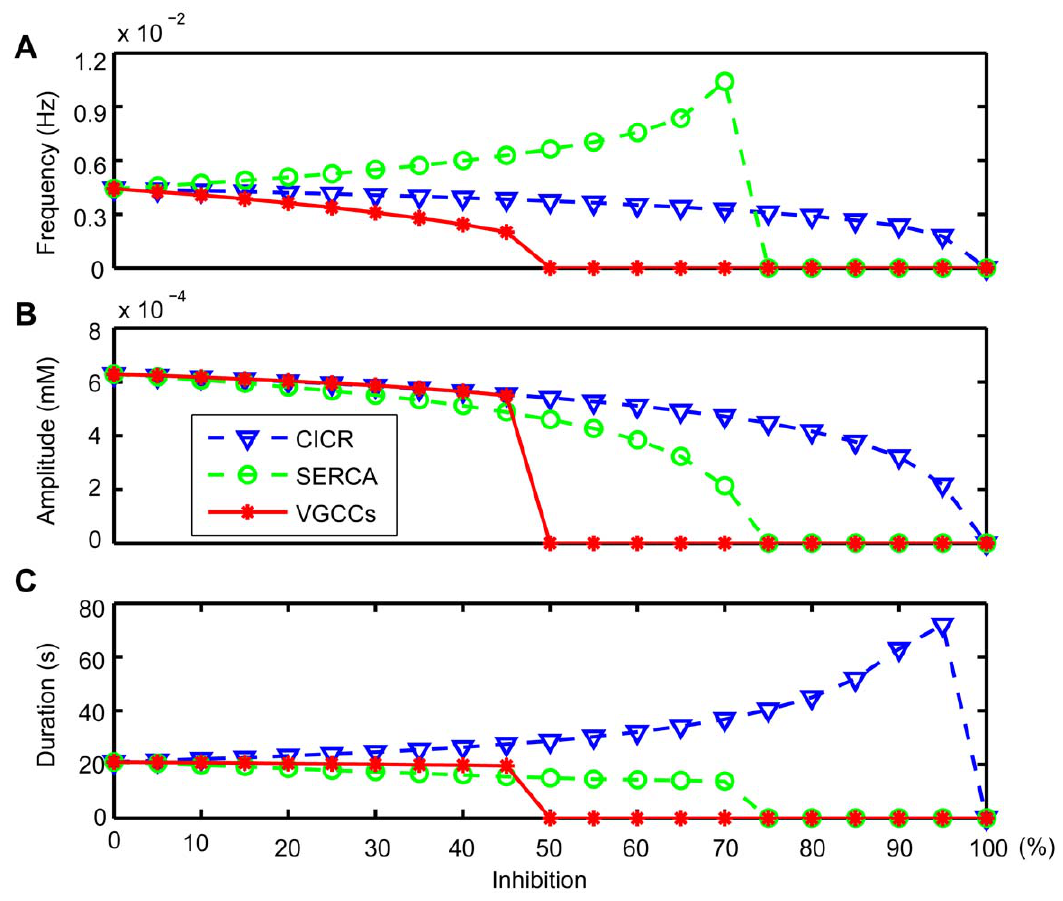
Figure 3. The influence of different Ca 2 + flows on CASs. By inhibiting CICR (dashed triangle), the frequency (A) and amplitude (B) of CASs decrease, but the duration (C) increases. CASs do not occur when CICR is inhibited more than 95%. By inhibiting SERCA (dashed circle), the frequency (A) of CASs increases, but both the amplitude (B) and the duration (C) decrease. CASs do not occur when SERCA is inhibited more than 70%. Inhibiting VGCCs (solid star) has little effect on the amplitude (B) and duration (C) but great on frequency (A) before CASs disappear. CASs do not occur when VGCCs are inhibited more than 45%.